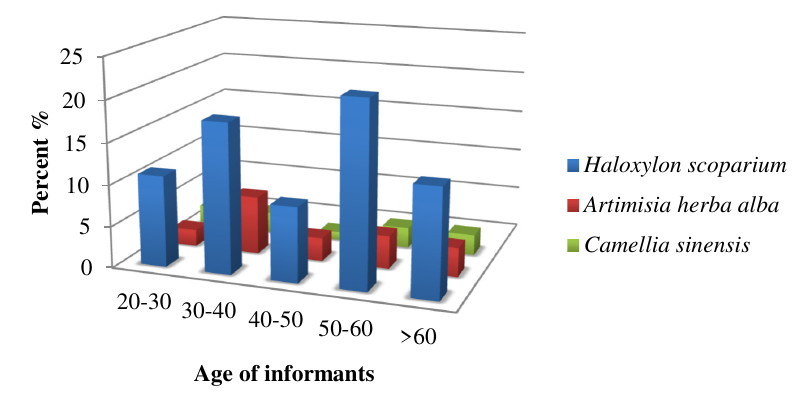
Figure 3. Frequency distribution of medicinal plant species used by the respondents of different age